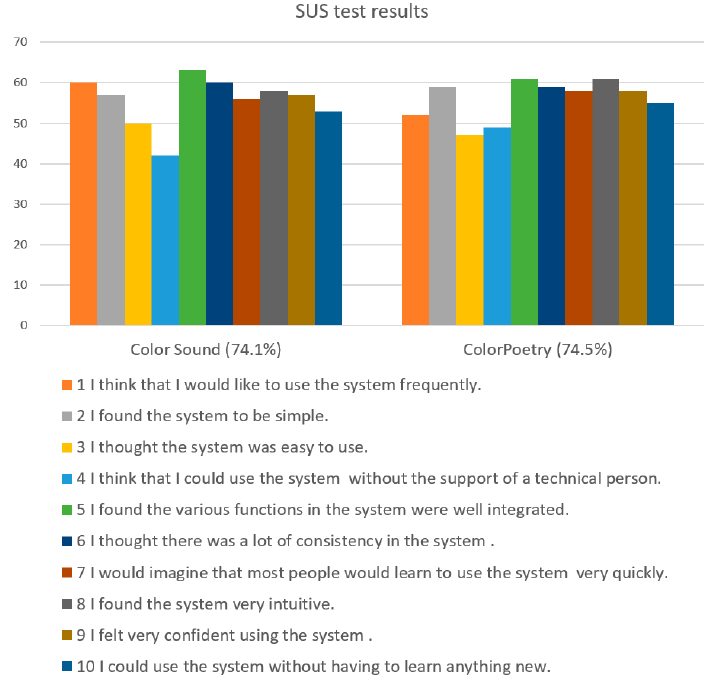
Figure 5. System Usability Scale test results.